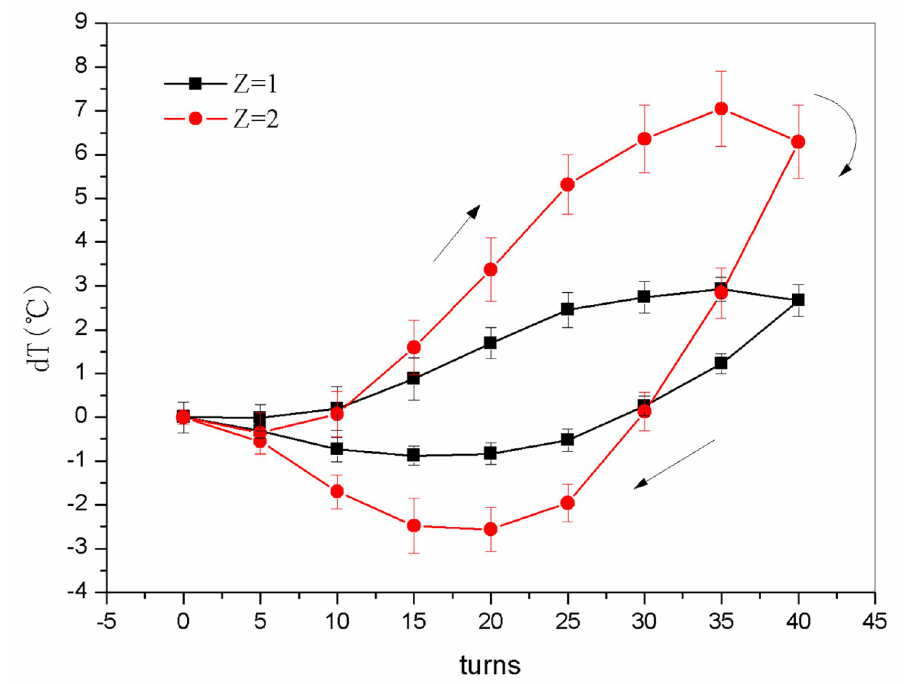
Fig 8. The temperature difference between the nitinol wire surface and the ambient air of the CTRS ( dT ) as a function of the number of alloy wires ( Z ) and twist turns.